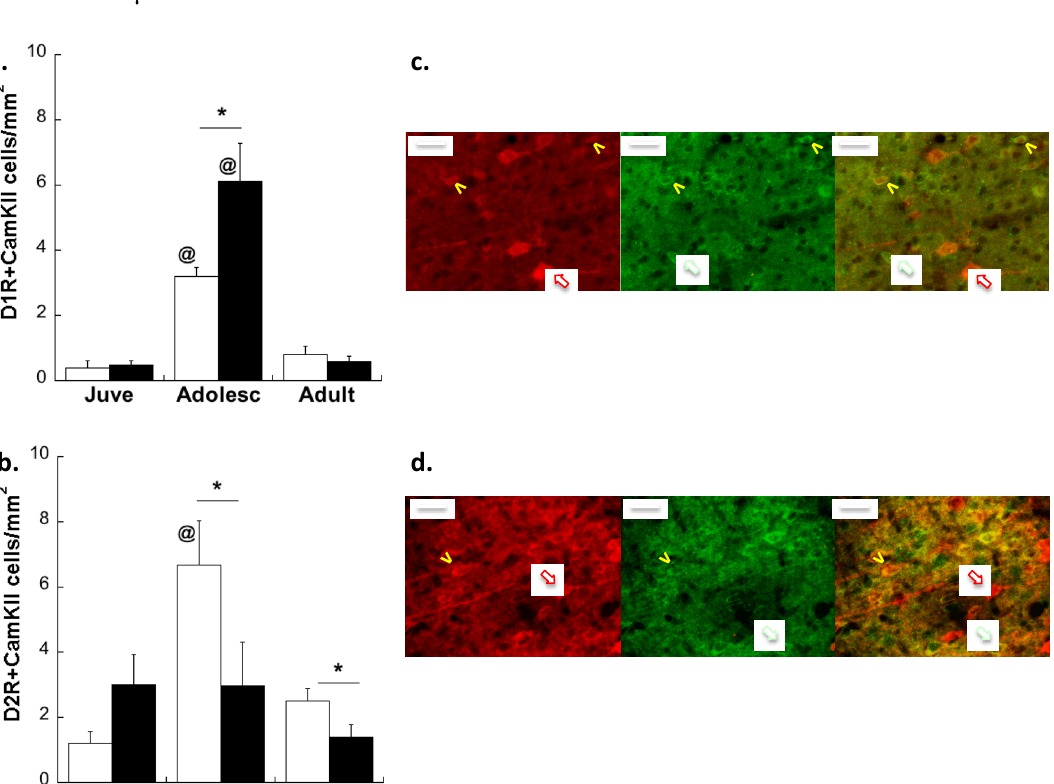
Figure 3. D1R ( a , c ) and D2R ( b , d ) expression changes on CamKIIa-IR glutamatergic neurons after MS in the plPFC. * p < 0.05 difference between groups using Bonferroni post-hoc t -tests after 2-way ANOVA. @ p < 0.05 difference from juveniles. White bars: CON; Black bars: MS. Averages ± SEM are presented. n = 5–6. Representative photomicrographs of individual channels and overlays from control adolescents taken at 40× are shown in ( c ) and ( d ). Red-outlined white arrows point to CamKIIa neurons, green-outlined white arrows point to D1R ( c ) or D2R ( d ) neurons, and yellow pointers point to co-localized neurons. Scale bar: 20